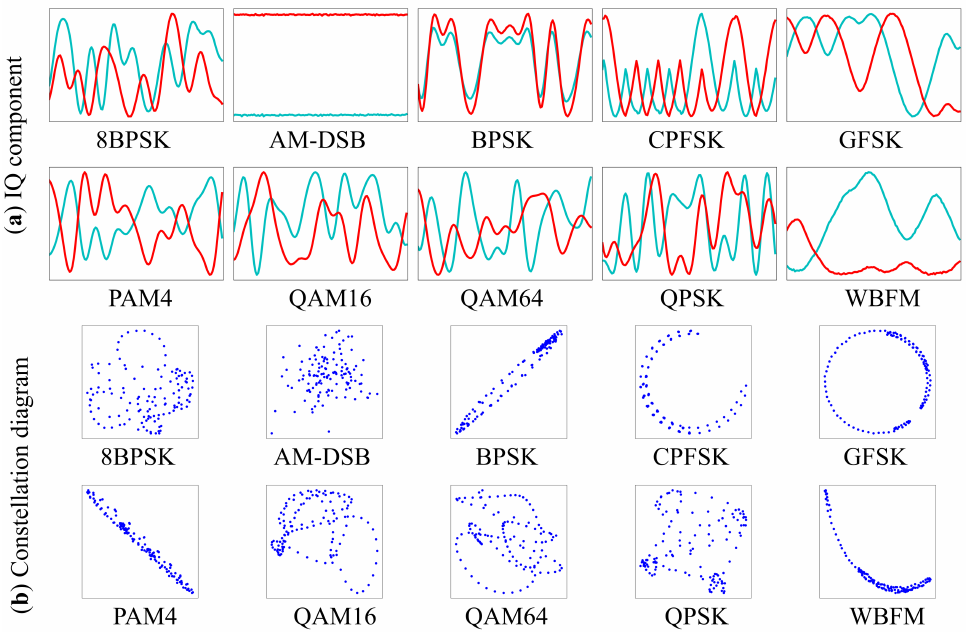
Figure 1. ( a ) IQ components and ( b ) constellation diagram examples of 10 different modulation types from 2016A with SNR = 18 dB. The cyan line represents the in-phase component, whereas the red line represents the quadrature